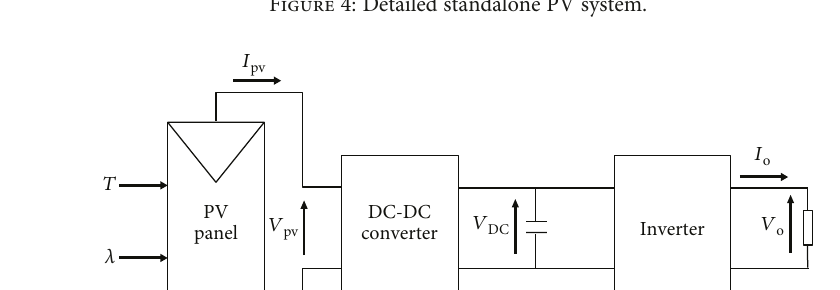
Figure 4: Detailed standalone PV system.